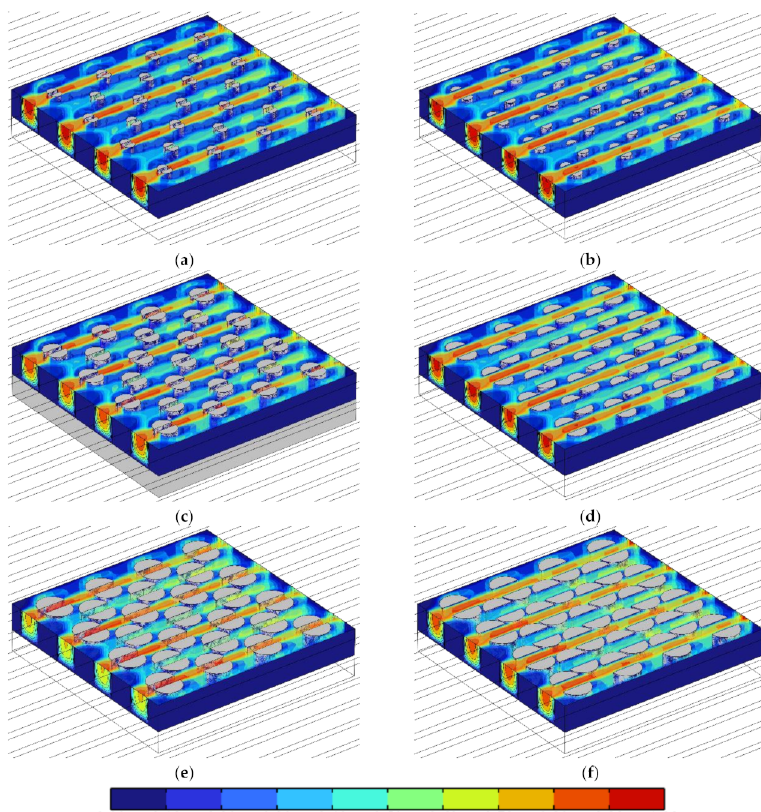
Figure 14. Velocity color maps of hotspot area of the hybrid heat sink with different L fin (unit m · s − 1